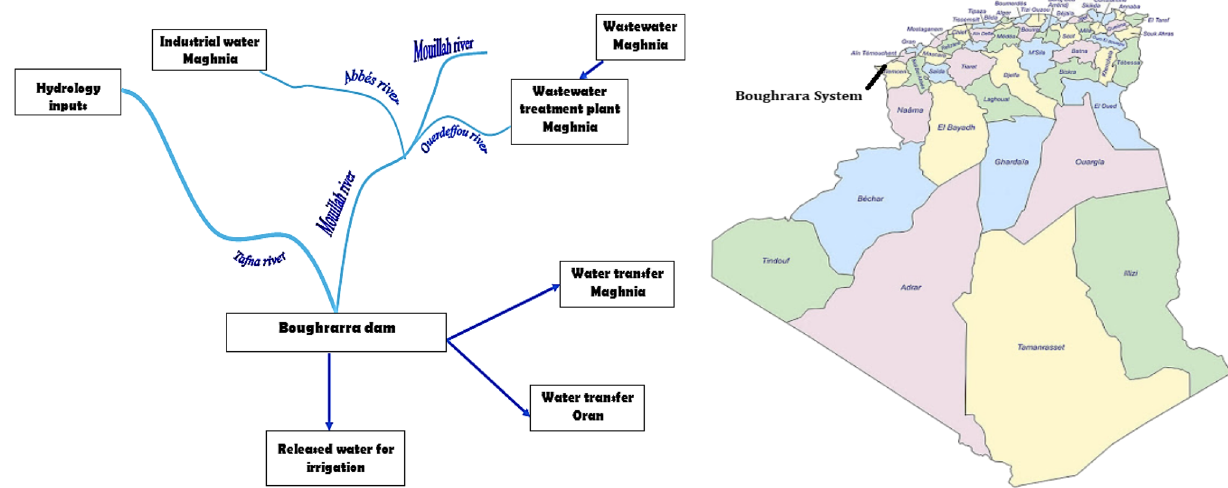
Fig. 2 Schematic exploration and identification of Boughrara